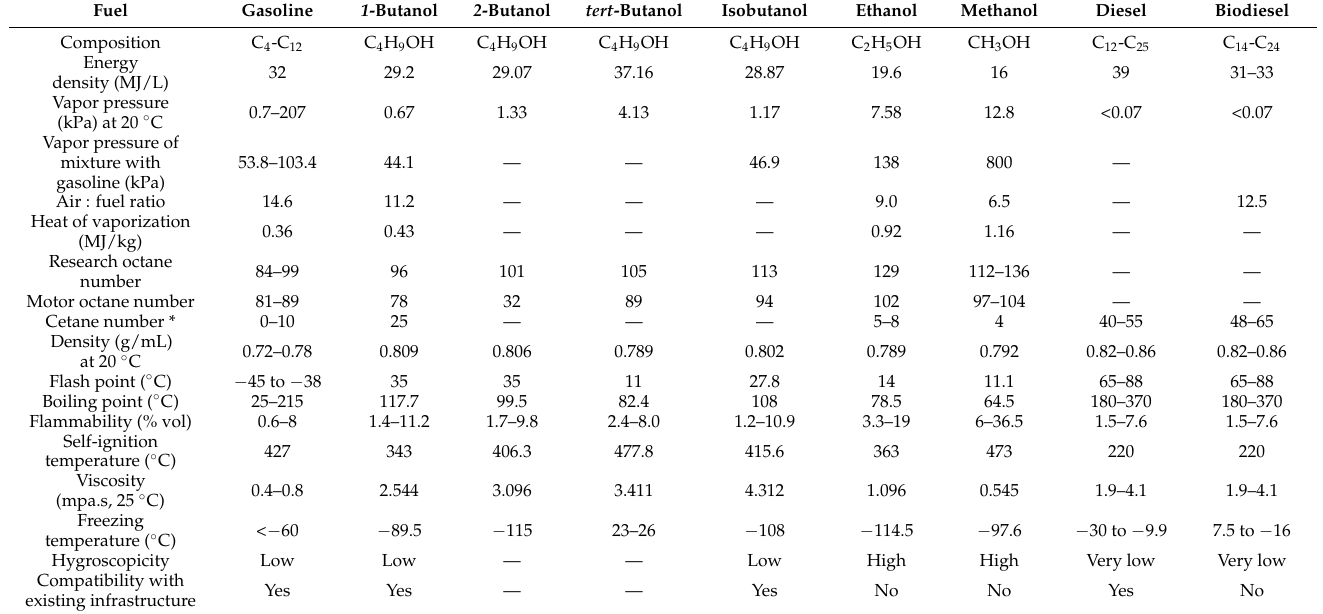
Table 4. Comparison of properties of different alternative liquid fuels